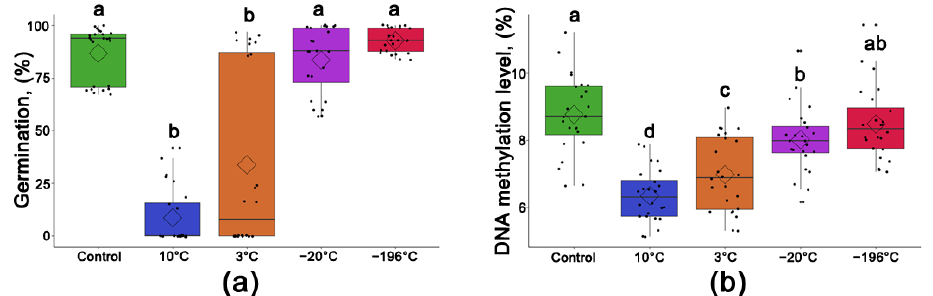
Figure 5. Average germination capacity ( a ) and levels of 5mC ( b ) of non-stored and stored, desiccated and non-desiccated Populus nigra L. seeds pulled from three seed lots. Control was composed of non-stored seeds. Separate statistical analyses were conducted for germination and 5mC level data. Statistical analysis was conducted on a GLM model with a binomial distribution ( a ) or LM ( b ) followed by ANOVA and a Duncan test. Values marked with the same letter are not significantly different at p < 0.05. Data represent mean ± SE, n = 24.